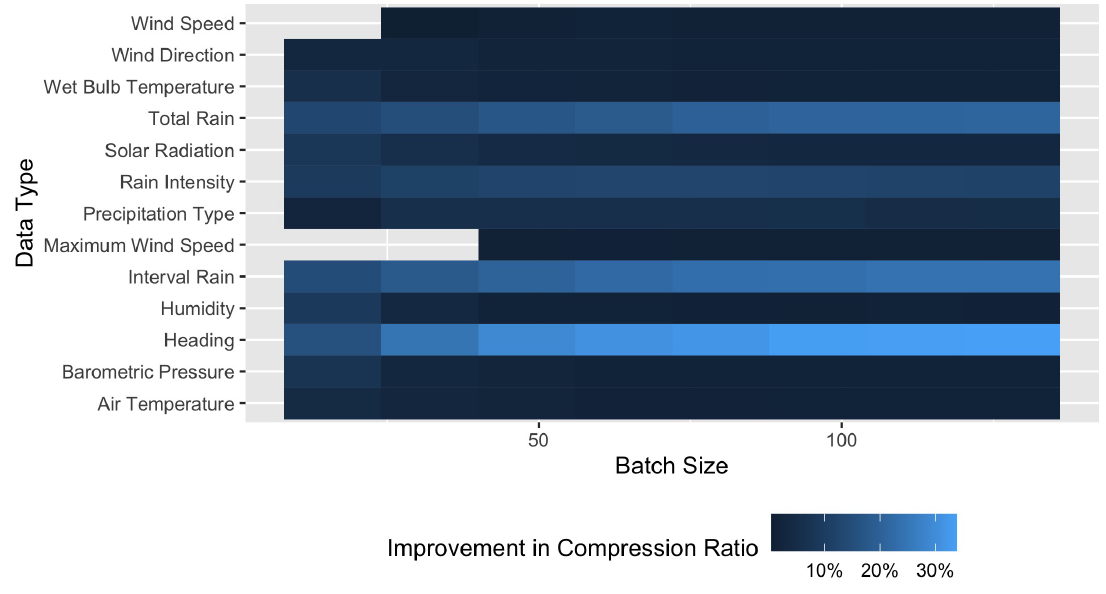
Figure 11. Relative improvement of the compression factor when multi-parameter Rice coding is used per data type.